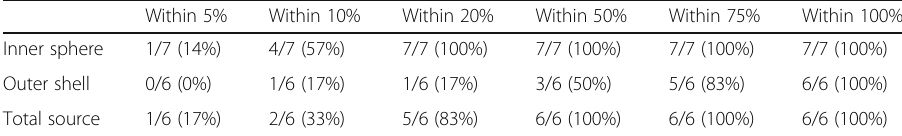
Table 3 Proportion of sites for which reported values were within the given percentage of the true value